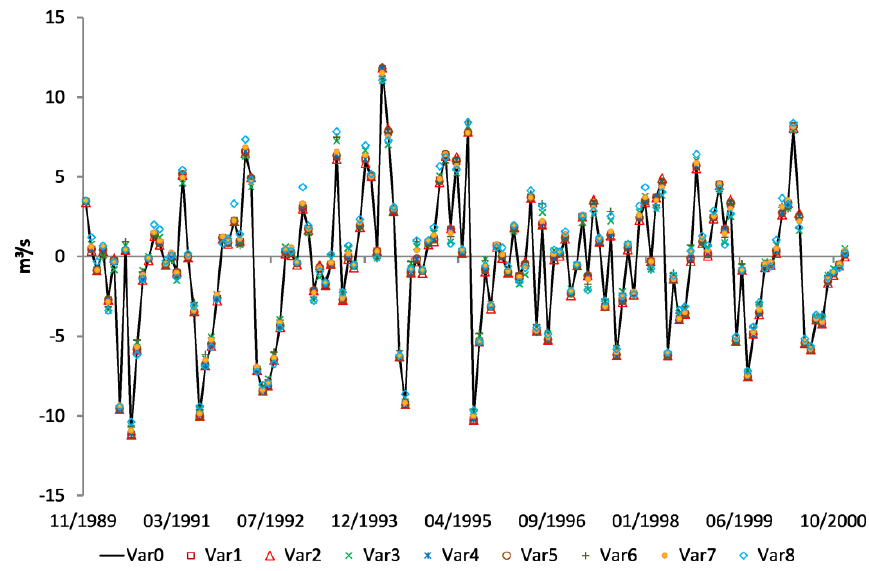
Figure 8. Monthly recharge R d (>0) and water withdrawal R W (<0) of the whole wetland for all variants.